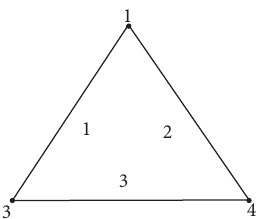
Figure 1: A classical mean labeling of C